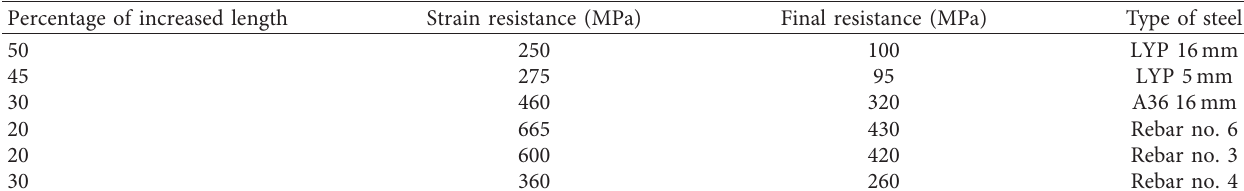
Table 1: Characteristics of steel.